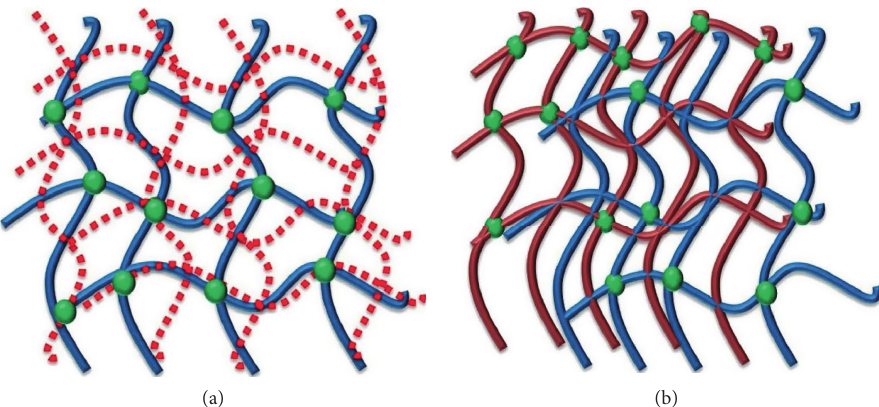
Figure 7: Schematic representation of (a) semi- and (b) full IPN. Blue line: polymer chain A; red line: polymer chain B; green sphere: crosslinked (adapted from